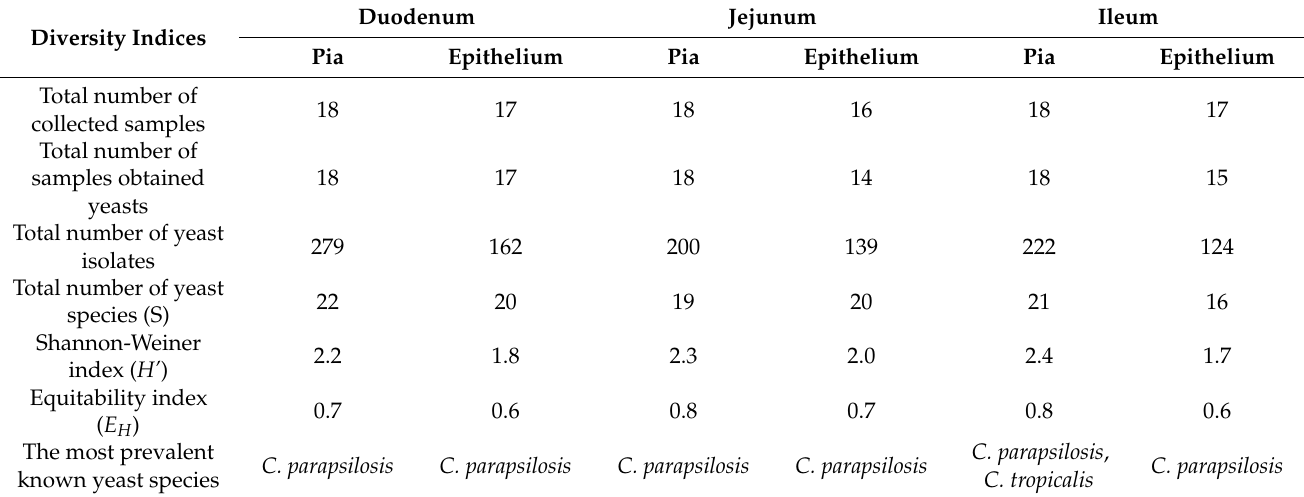
Table 2. Diversity indices of yeasts from the pia and epithelium from all three parts of the small intestine. Duodenum Jejunum Ileum Diversity Indices Epithelium